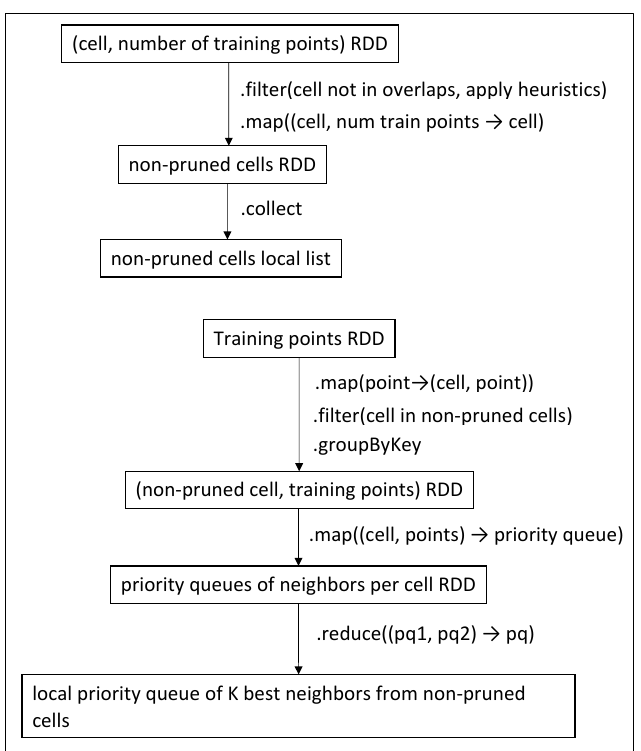
Figure 8. Discover neighbors in non-pruned cells (Phase